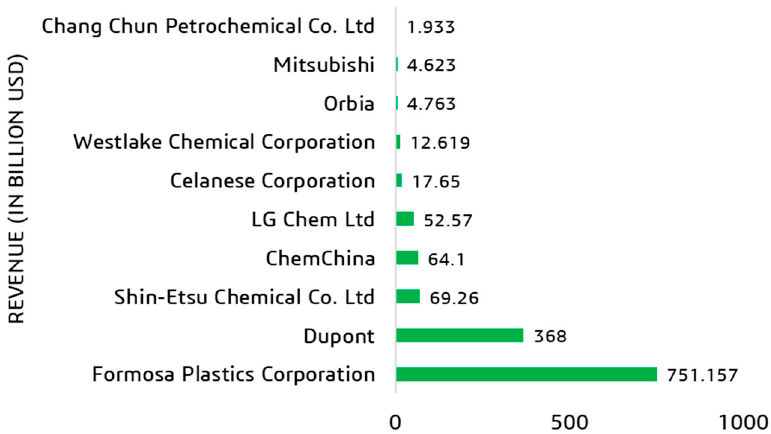
Figure 2. World’s Leading PVC Manufacturers in Terms of Market Capitalization (in billion USD for the year 2022) [13].